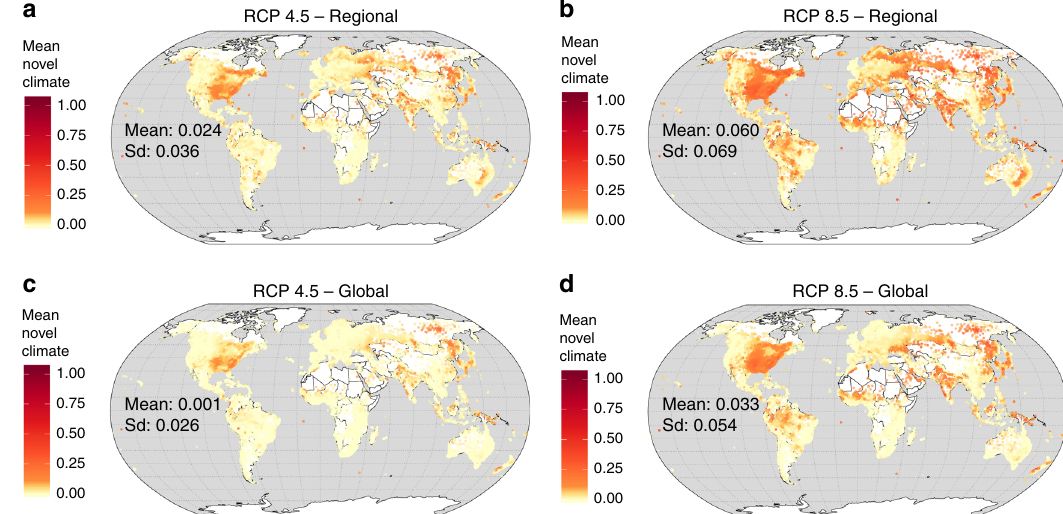
Fig. 4 Regional- and global-scale novel climate index of terrestrial protected areas worldwide. The regional-scale novel climate index shows the proportion of raster cells inside a PA that hold climate classes in the future which are currently not present in the entire PA network of the respective biome. The global-scale novel climate index indicates the proportion of raster cells inside a PA that hold climate classes in the future which are currently not present in the global PA network. The mean of the novel climate indices comprise future climate data from ten GCMs under RCP 4.5 and 8.5. a Mean of the regional, biome-speci fi c novel climate index under RCP 4.5. b Mean of the regional, biome-speci fi c novel climate index under RCP 8.5. c Mean of the global-scale novel climate index under RCP 4.5. d Mean of the global-scale novel climate index under RCP 8.5. For each metric in a – d the mean across all 137,432 PA values are also given inside the global maps. Data on climate change metrics and other characteristics per PA are given as Supplementary Data 1. The maps were created using open-source software R